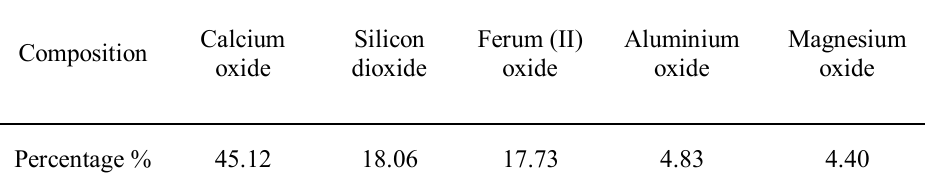
Table 1. Composition of EAFS used in this